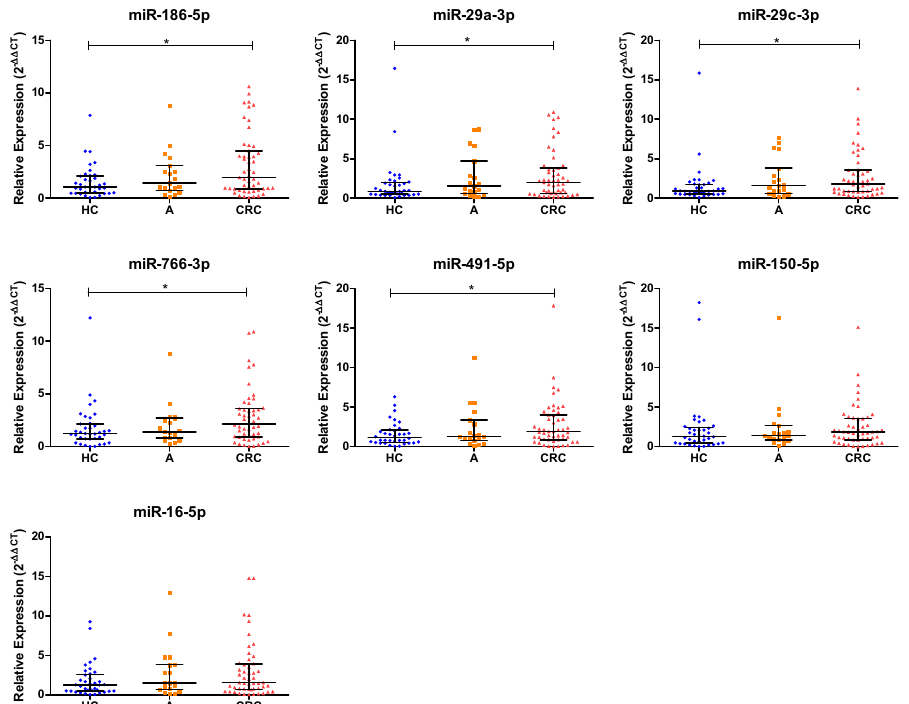
Figure 2. Salivary miRNA expression levels in healthy controls, adenomas and CRC patients in the validation phase of the study. The relative expression levels of selected salivary miRNAs were normalized to endogenous control (miR-193b-3p). The two-tailed Mann–Whitney U test was performed to examine the difference between groups of seven miRNAs (* p < 0.05). Note: HC, healthy controls; A, adenomas; CRC, colorectal cancer; miRNAs, microRNAs. ROC curve analyses were also performed to determine the diagnostic value of the five validated miRNAs (miR-186-5p, miR-29a-3p, miR-29c-3p, miR-766-3p and miR-491-5p) for CRC detection. Importantly, all miRNAs showed good power to discriminate CRC patients from healthy controls with AUC up to 0.659. Importantly, the combined analysis of the five miRNAs showed a higher AUC (0.754), with a sensitivity of 72% and a specificity of 66.67%, differentiating CRC patients from healthy individuals (cut-off value = 0.5132) (Figure 3 and Table S3). Internal validation of the five-miRNA panel showed a bootstrap optimism-corrected AUC value of 0.744 (95% CI = 0.649 to 0.844) for discriminating CRC patients from healthy controls.